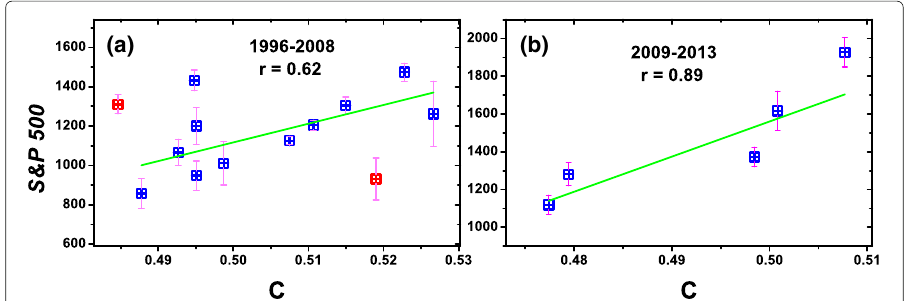
Fig. 5 The network Index C versus the annual average S&P 500 Index of next year. a The years from 1996 to 2008, i.e before financial crisis. b The years from 2009 to 2013, i.e after financial crisis. The straight lines show the best linear regression with correlation